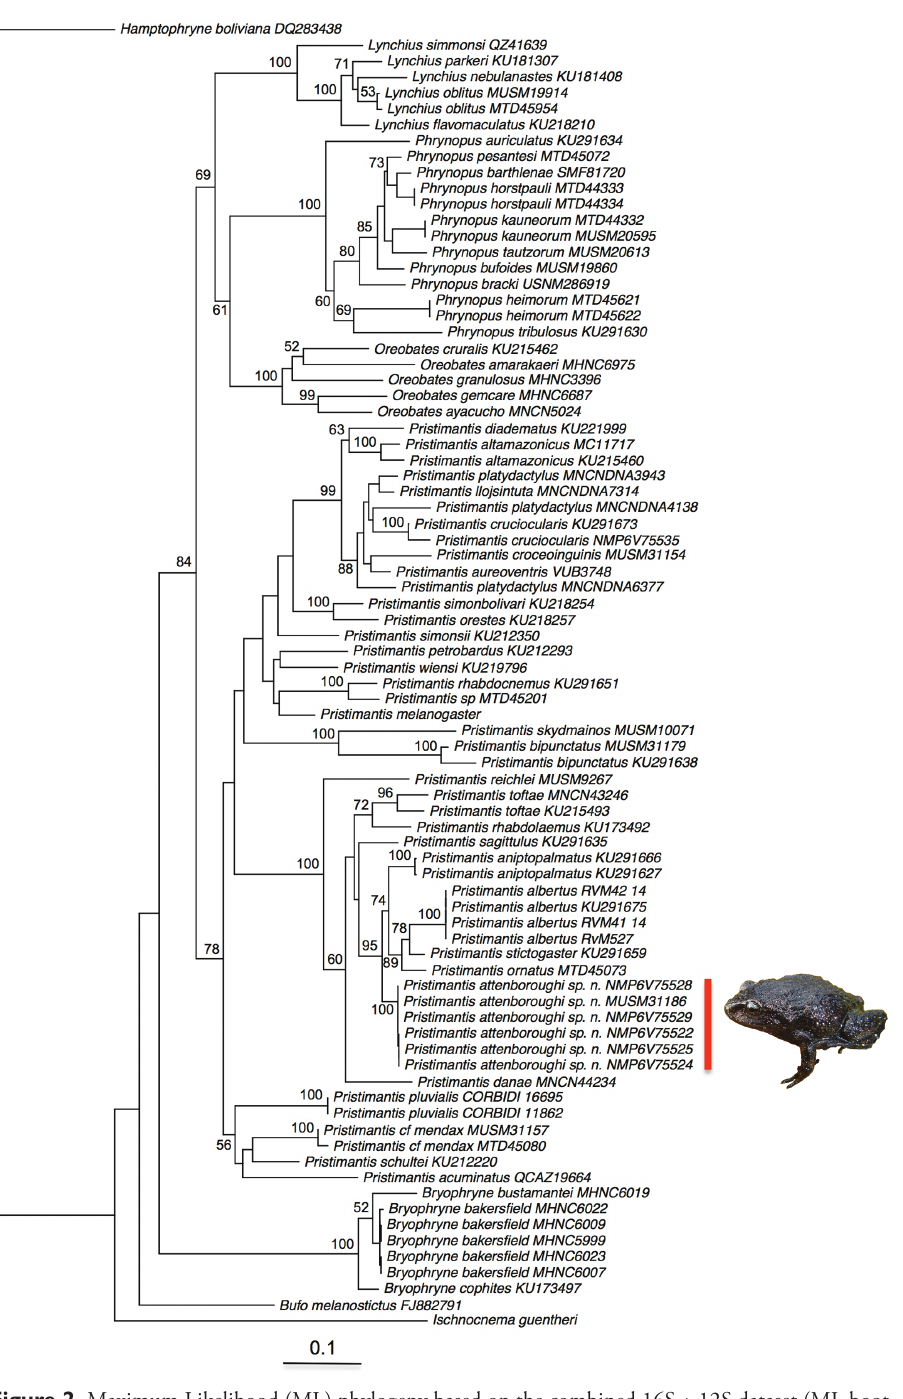
Figure 2. Maximum Likelihood (ML) phylogeny based on the combined 16S + 12S dataset (ML boot- strap values >50 are indicated at each